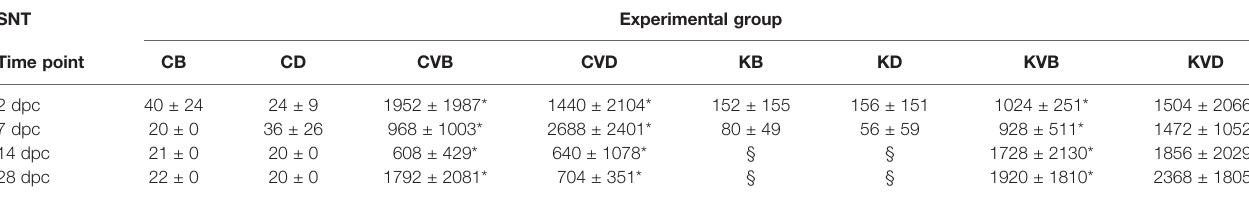
The description of experimental groups: CB – BSA, non-vaccinated, unchallenged control, CD – defensins, non-vaccinated, unchallenged control, CVB – BSA, vaccinated, unchallenged control, CVD – defensins, vaccinated,unchallenged control,KB -BSAnon-vaccinated,CyHV-3 challenged,KD – defensins non-vaccinated,CyHV-3 challenged,KVB – BSA,vaccinated, CyHV-3challenged,KVD – defensins,vaccinated,CyHV-3challenged.Theresultsarepresentedasamean±SDofthehighestserumdilutioninactivatingtheCyHV-3.§indicatesthat fi sh from these experimental groups had to be removed before the time point due to pathological changes.* indicates statistical signi fi cant difference when compared with the control at p < 0.05. Statistical analysis was performed with two-way ANOVA with multiple comparisons test performed with the Holm-Sidak